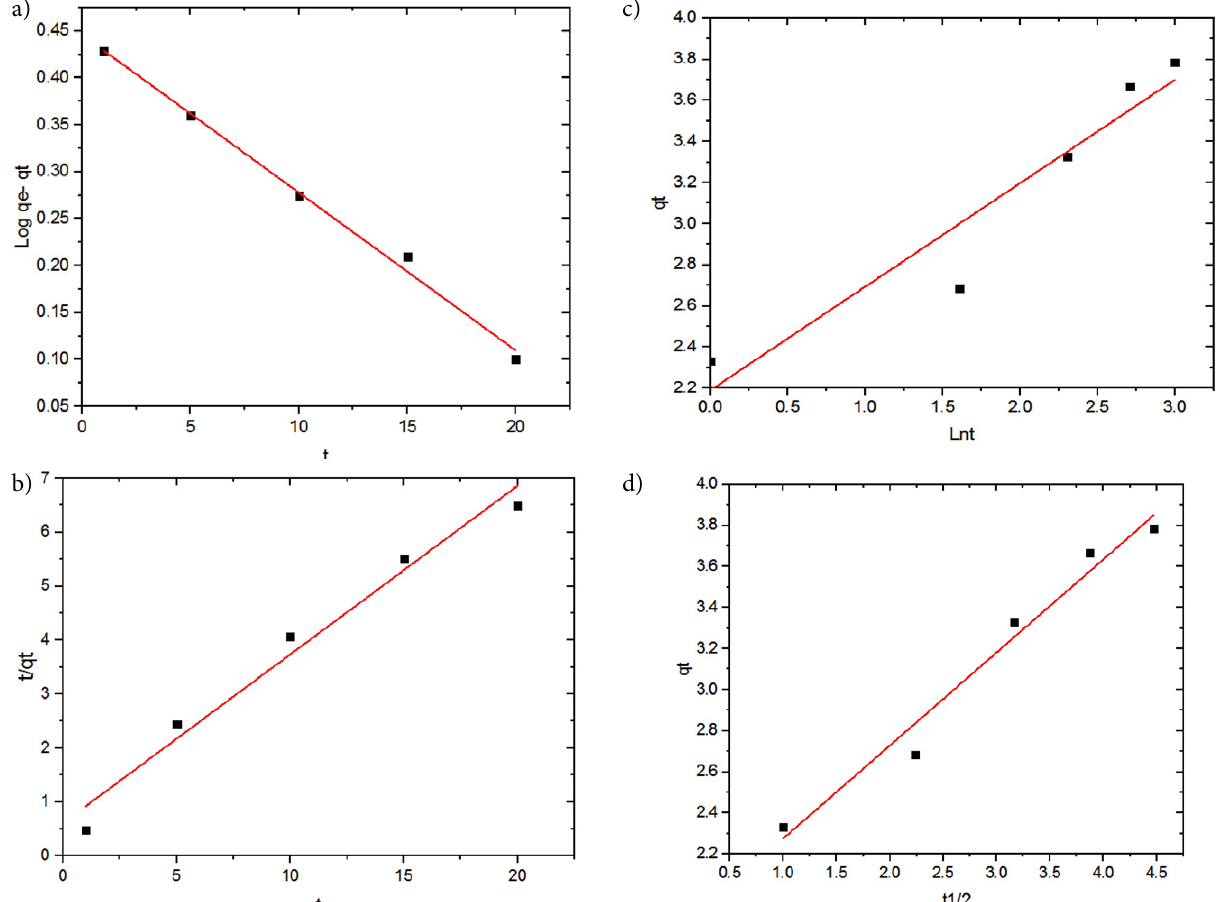
Figure 14. Kinetics analysis of the drug adsorption on fabricated nanocomposite (a) fitting by the first-second-order model (b) fitting by the pseu- do-second-order model; (c) fitting by Elovich model; (d) fitting by the intraparticle diffusion Table 2. The kinetic parameters of adsorption